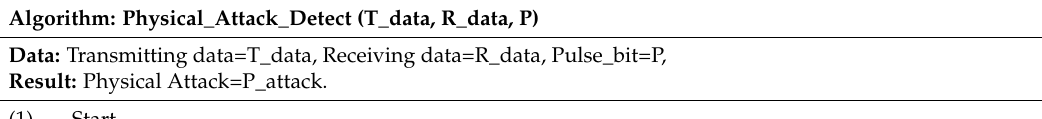
Table 2. Pseudocodes used to detect Physical Attack in the proposed SIF using Zigbee